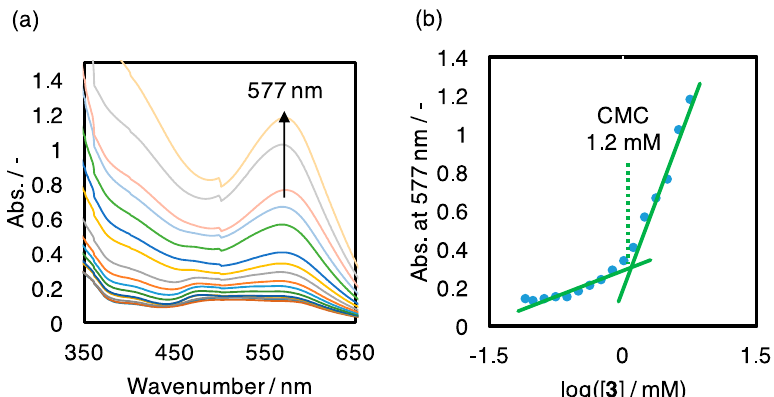
Figure 7. ( a ) Absorption spectra of nile red depending on coexisting complex 3 in aqueous solutions ([ 3 ] = 0.08–5.68 mM, [nile red] = 10 µM). ( b ) Plots of absorbance at 577 nm vs. the concentration of 3